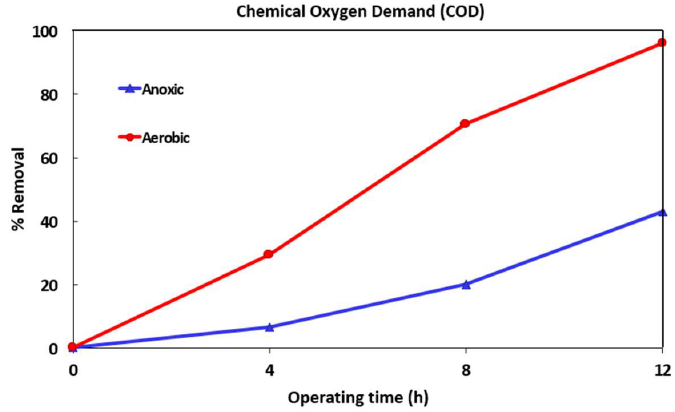
Figure 2. Percentage COD removal during 12-h MBR operation. TSS (total suspended solids) in the anoxic and aerobic tanks was about 5100 and 6500 mg/L respectively.